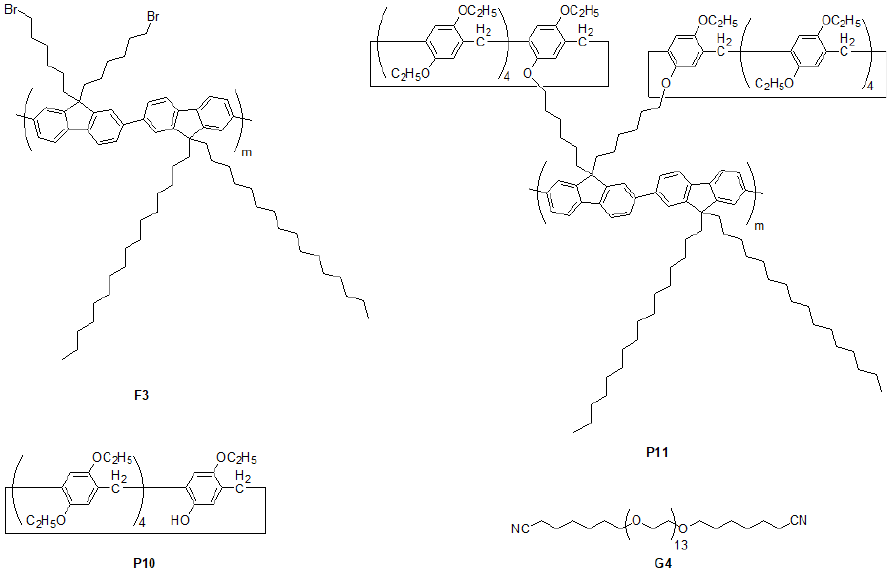
Scheme 4. Chemical structures of polymer F3 , pillar[5]arene P10 , pillar[5]arene-based polymer P11 and PEG derivative G4 [85].